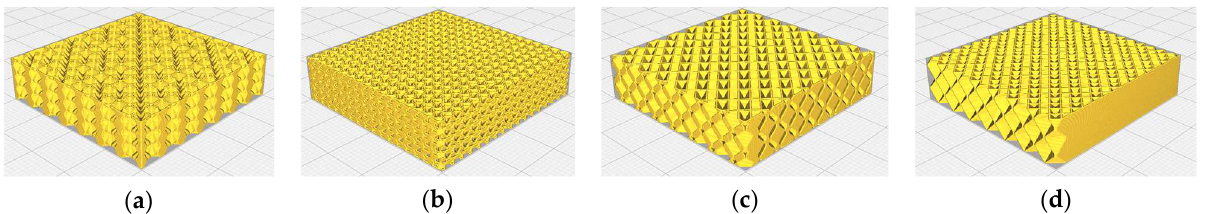
Figure 1. The top views of a prismatic volume (40×40×10 mm 3 ) with various infill patterns defined by 2D models: ( a ) grid, ( b ) triangles, ( c ) concentric, ( d ) cross.